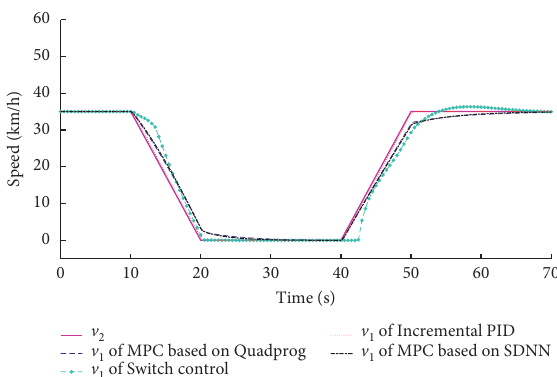
Figure 16: Speeds of the LV and the FV of four